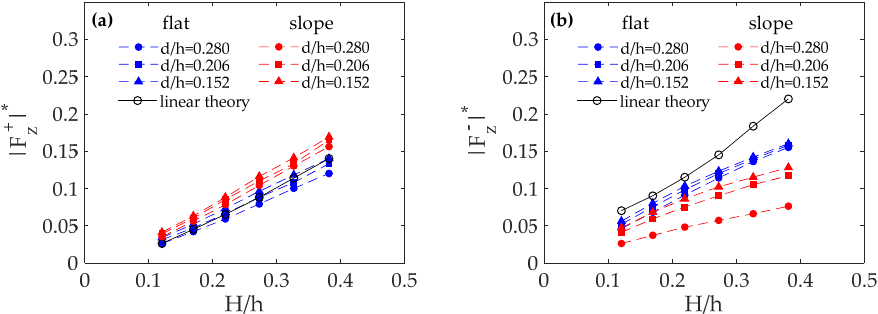
Figure 12. The horizontal wave forces due to solitary waves in terms of the different wave force components ( a ) positive horizontal wave force and ( b ) negative horizontal wave force. The theoretical results from linear theory for flat bottoms are compared with the experimental data for both flat bottoms and slope in the figure, as well as in Figures 13 and 14.